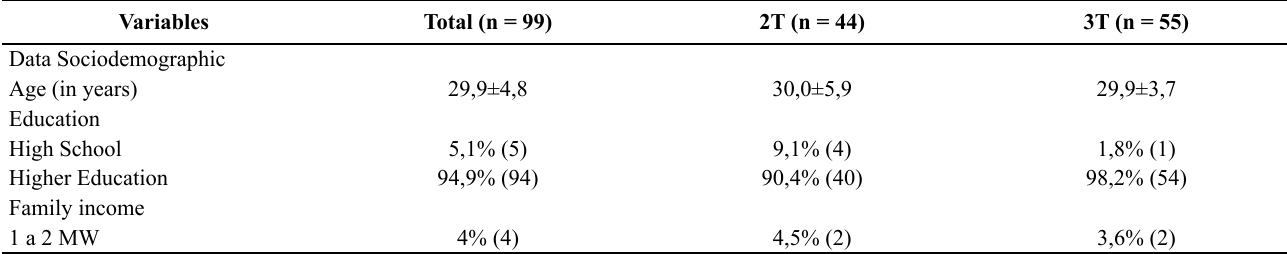
Table 1- Sociodemographic, clinical, obstetrical, anthropometric, and lifestyle characteristics of the total sample (n = 99).